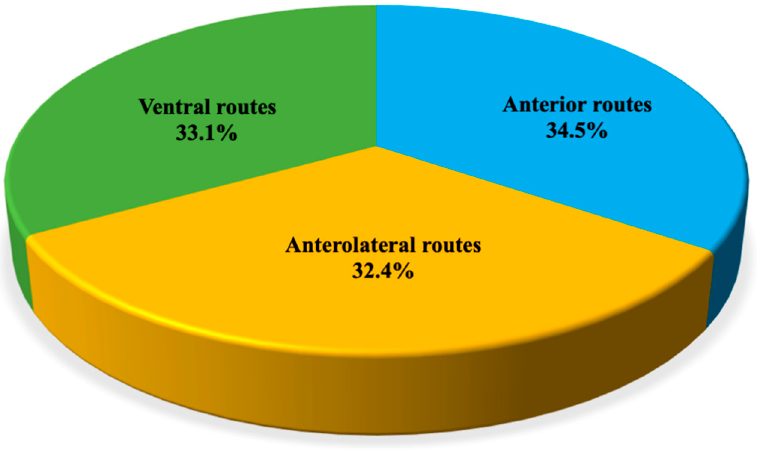
Figure 1. Distribution of papers addressing olfactory groove meningiomas (OGMs) per surgical cor- ridor.